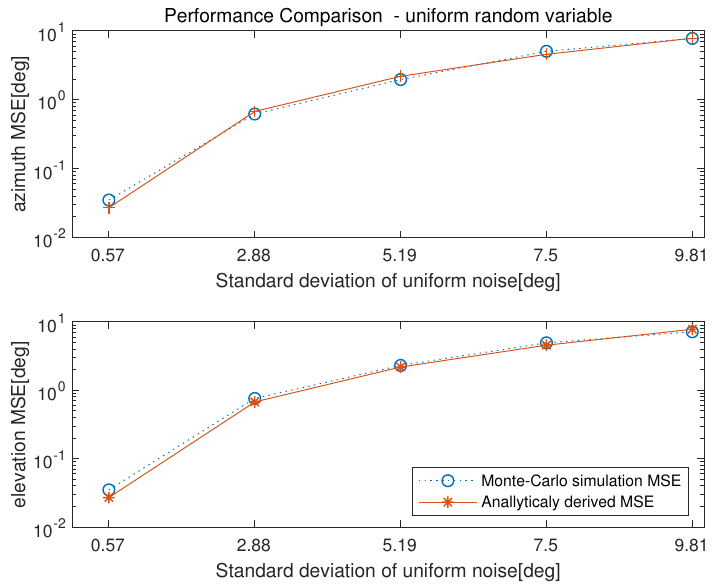
Figure 6. Performance for uniformly − distributed phase measurement error with θ ( 0 ) = 120 ◦ and ψ ( 0 ) = 45 ◦ . This figure shows the MSEs of azimuth and elevation with respect to phase error at a signal with medium incident elevation. It can be confirmed that the MSE of elevation is similar to that of the azimuth at medium elevation(uniform circular array).